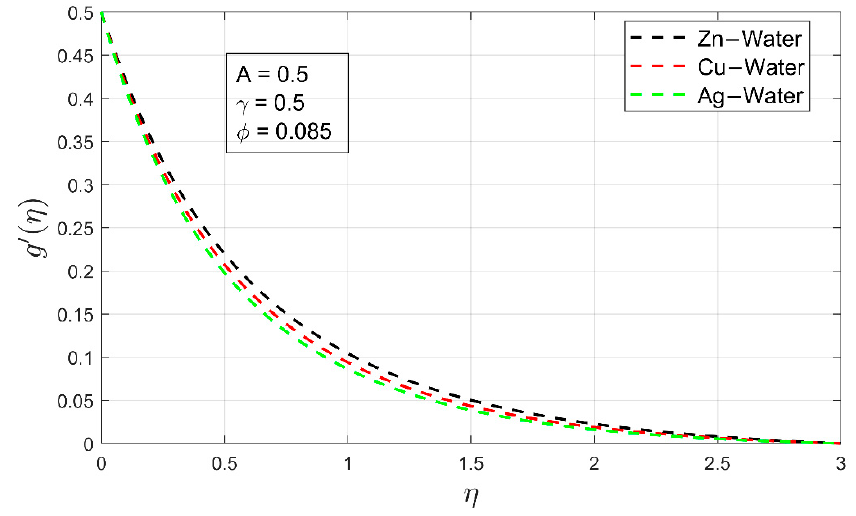
Figure 3. Comparison of velocity profiles (cid:1859)′ ((cid:2015)) for different nanofluid.